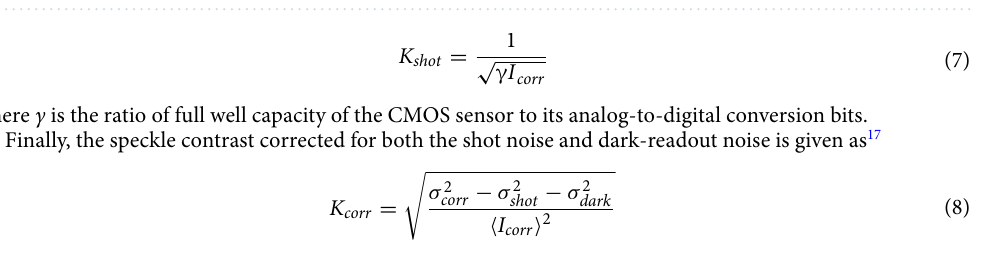
Figure 6. Imaging set up and acquisition modes (A) Modulated laser mode set-up (mode 1). AWG arbitrary waveform generator, AOM acousto-optic modulator. (B) Synthetic exposure mode set-up (mode 2). (C) Modulated laser acquisition scheme. N is the number of different exposures at which the speckle patterns are recorded. The camera exposure time T is fixed and the laser is modulated in duration t and intensity I . (D) Synthetic exposure acquisition scheme. The laser is operated in continuous mode, its intensity I is fixed, the camera exposure time is fixed and set to the shortest exposure time T 1 . For both modes, Δi is the camera interframe